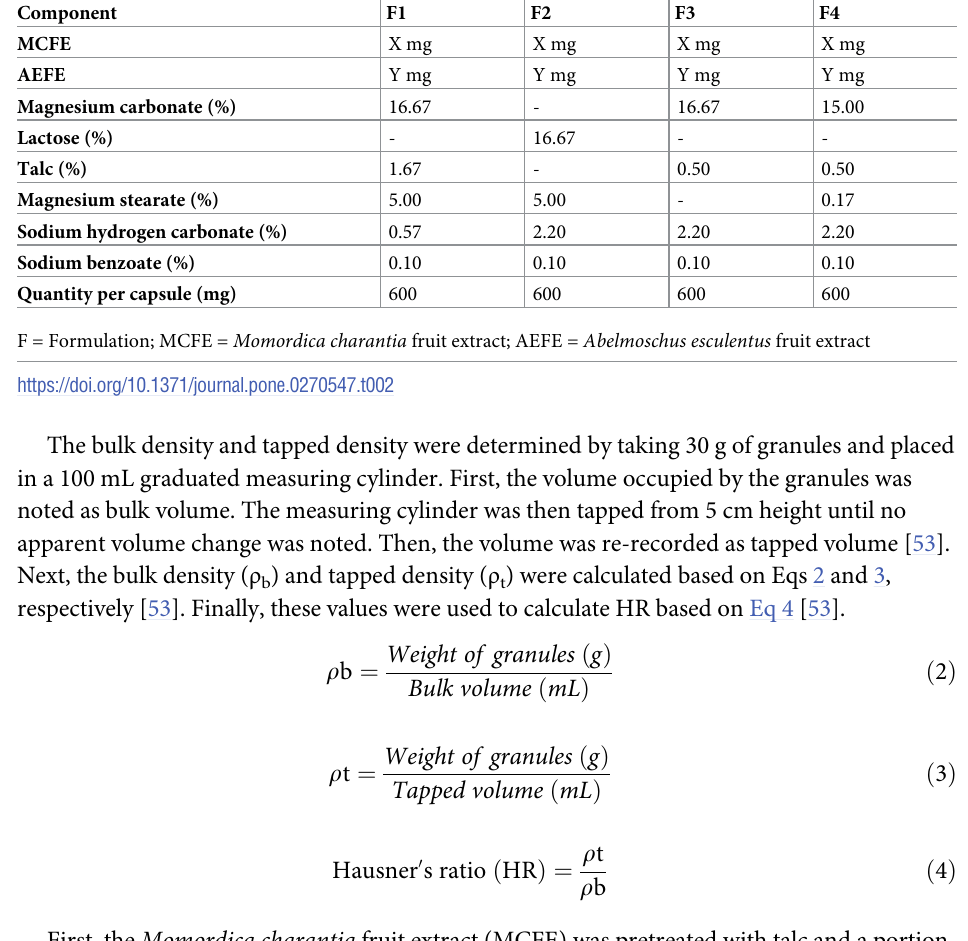
Magnesium carbonate (%)